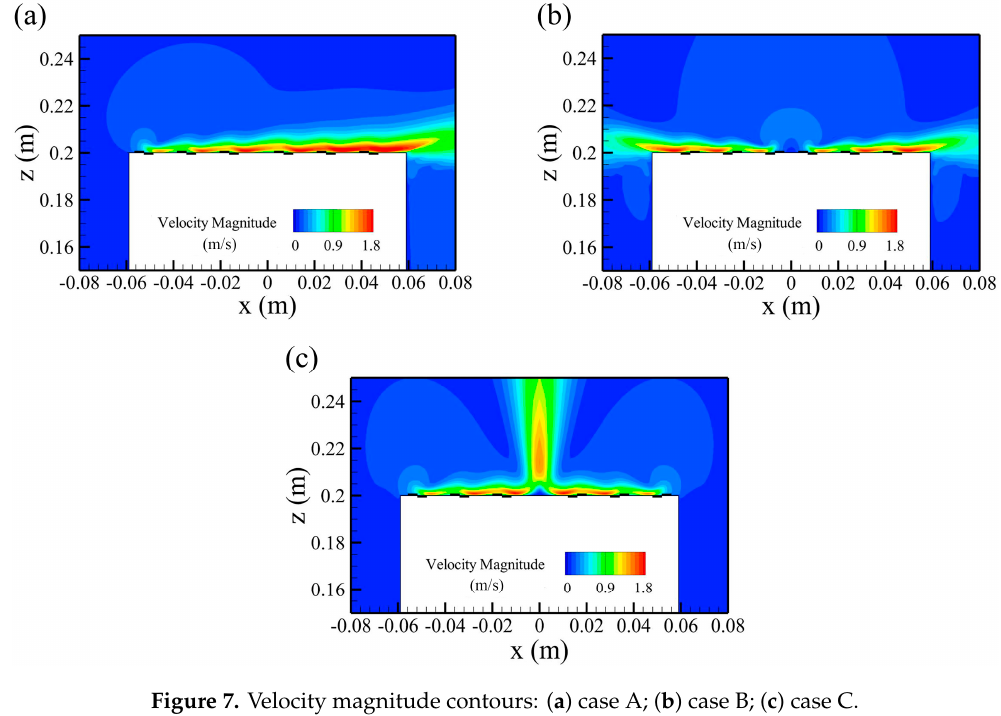
Figure 7. Velocity magnitude contours: ( a ) case A; ( b ) case B; ( c ) case C.